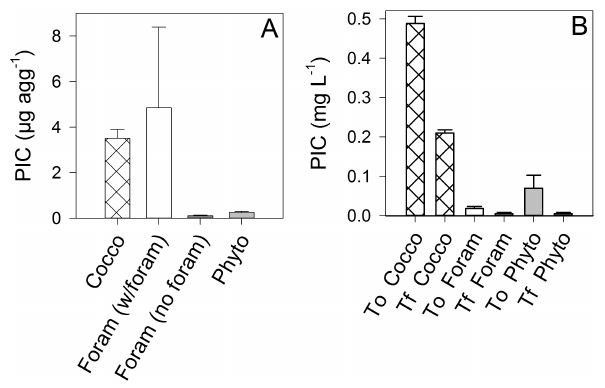
Fig. 4. Concentrations of PIC (in µgC) in (A) aggregates at the end of the experiment and (B) suspended in the water in the tanks of the different treatments at the beginning (T 0 ) and end (T f ) of the